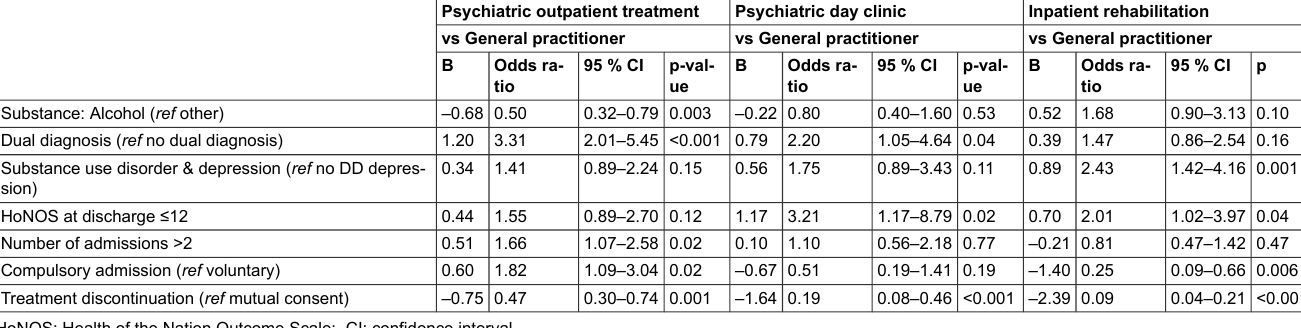
Table 3: Length of stay in inpatient withdrawal treatment and readmissions within 12 months according to the four settings of aftercare.